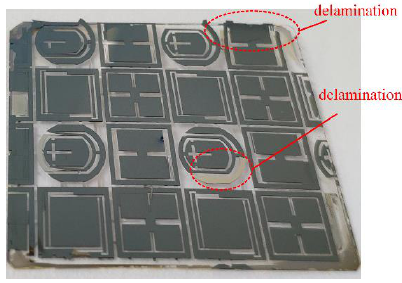
Figure 12. The delamination issue of the Cr layer induced by residual stress.